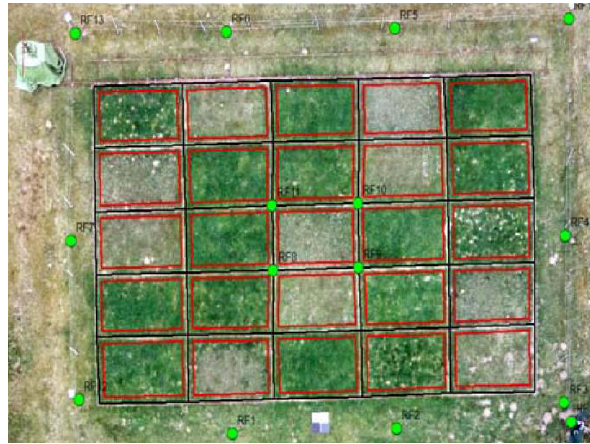
Figure 1. The RGE experiment (Bareth et al. 2015) For the non-destructive UAV-based monitoring, a DJI Phantom 2 was purchased and a Canon Powershot 110 digital compact camera was mounted using a fixed camera mount. The system is shown in Fig.2. For data acquisition, a manual flight pattern in approx. 20 m above ground was flown. Continous image acquisition was realized with a CHDK software installed on the camera’s SD card. Every second an image was taken. The spatial resolution of the images is approx. 1 cm.